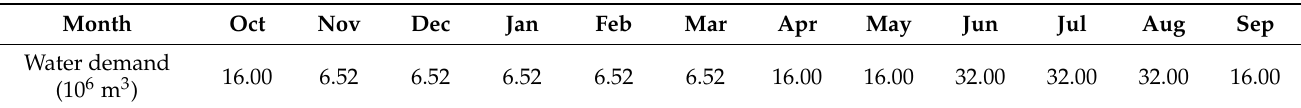
Figure 3. Exceedance probability with respect to any reservoir volume for the regulation periods r = 1, 2, 3 and 10 years derived for the actual runoff data (1956–2012) using the scenario proposed in Table 1 and shown in Figure 2 in the blue line. Table 1. Alternative water management scenario of hydroelectricity production and irrigation supplement for the future Ladhon Reservoir operation as a multipurpose